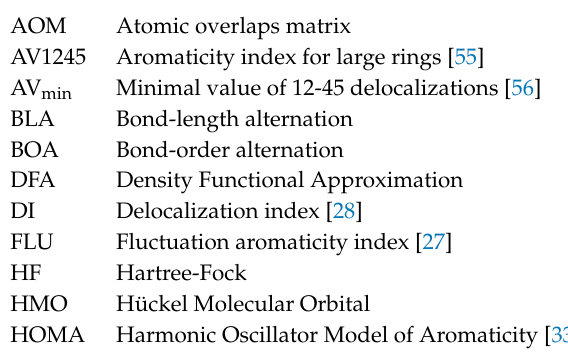
Supplementary Materials: The Cartesian coordinates of the molecules as well as full tables and